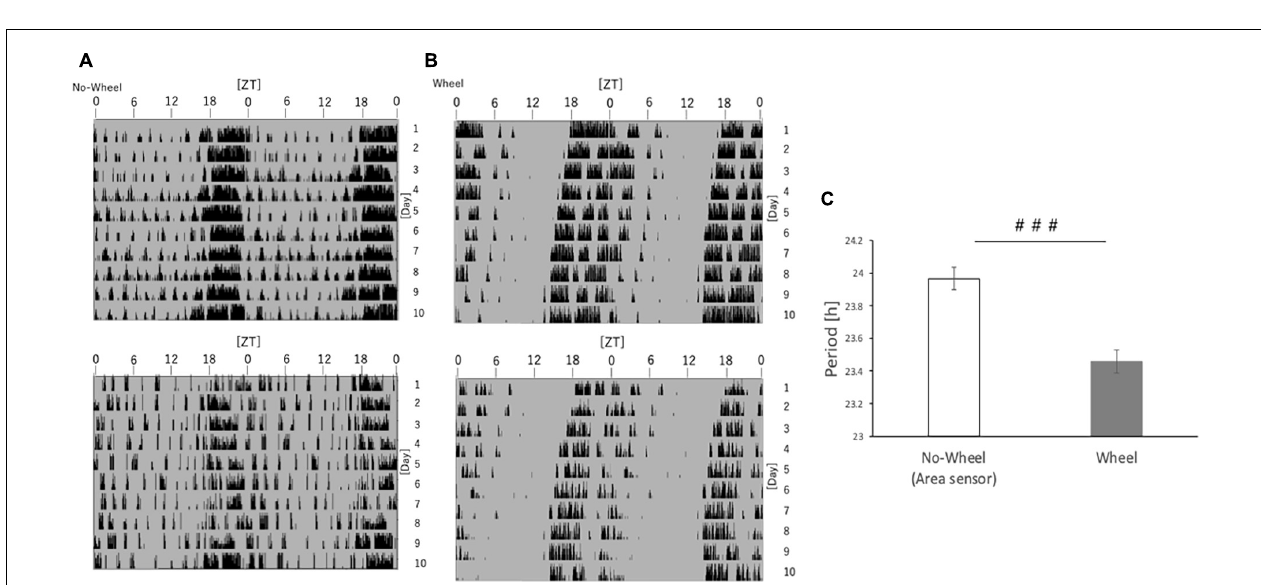
FIGURE 7 | Free-running cycle of mice under DD condition. (A) Representative double-plot actograms of the behavior of mice reared under DD conditions for 10 days as measured by an infrared sensor. (B) Representative double-plot actogram of behavior measured by a wheel-running device during 10 days of rearing under DD condition. (C) Free-run cycle calculated from behavioral rhythms. Data are presented as mean ± standard error of the mean (No-Wheel, n = 9; Wheel, n = 7). ### p < 0.001 (Mann-Whitney test).